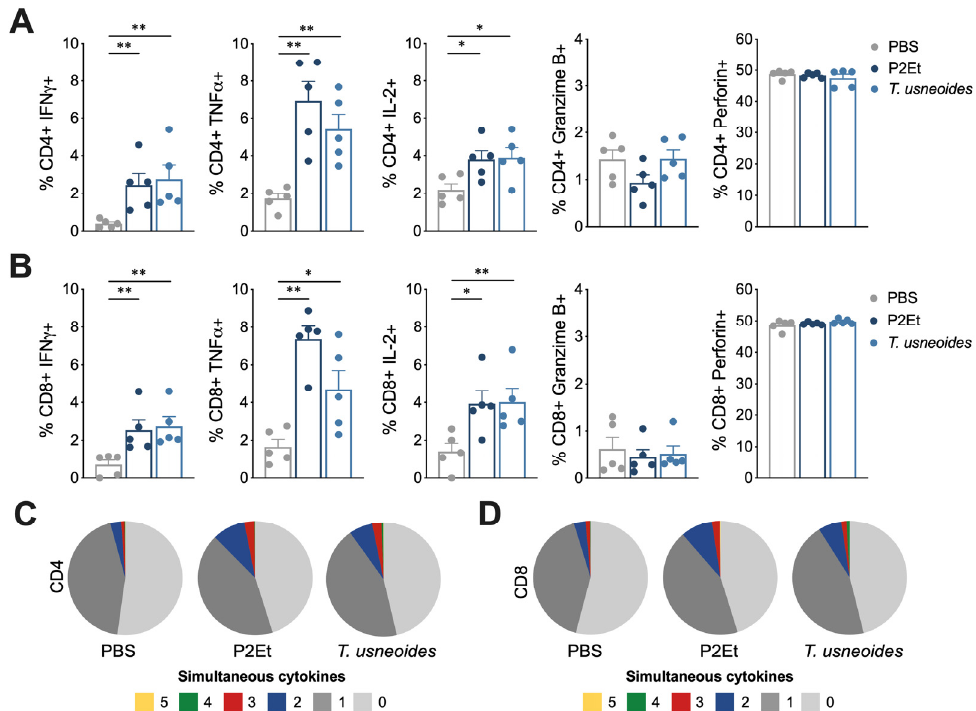
Figure 6. T. usneoides extract modulate functional activity of T cells in the breast cancer model. ( A ). Frequency of CD4 + T cells from spleen producing IFN γ , TNF α , IL ‐ 2, Granzyme B, and Perforin following stimulation with PMA/ionomycin (P/I). ( B ). Frequency of CD8 + T cells from spleen producing IFN γ , TNF α , IL ‐ 2, Granzyme B, and Perforin following stimulation with P/I. Polyfunctional activity of CD4 + ( C ) or CD8 + ( D ) T cells from spleen, following stimulation with P/I, from each group of treatment. The functional profiles are grouped and color ‐ coded according to the number of functions, as shown in the pie charts. * p < 0.05, ** p < 0.01.